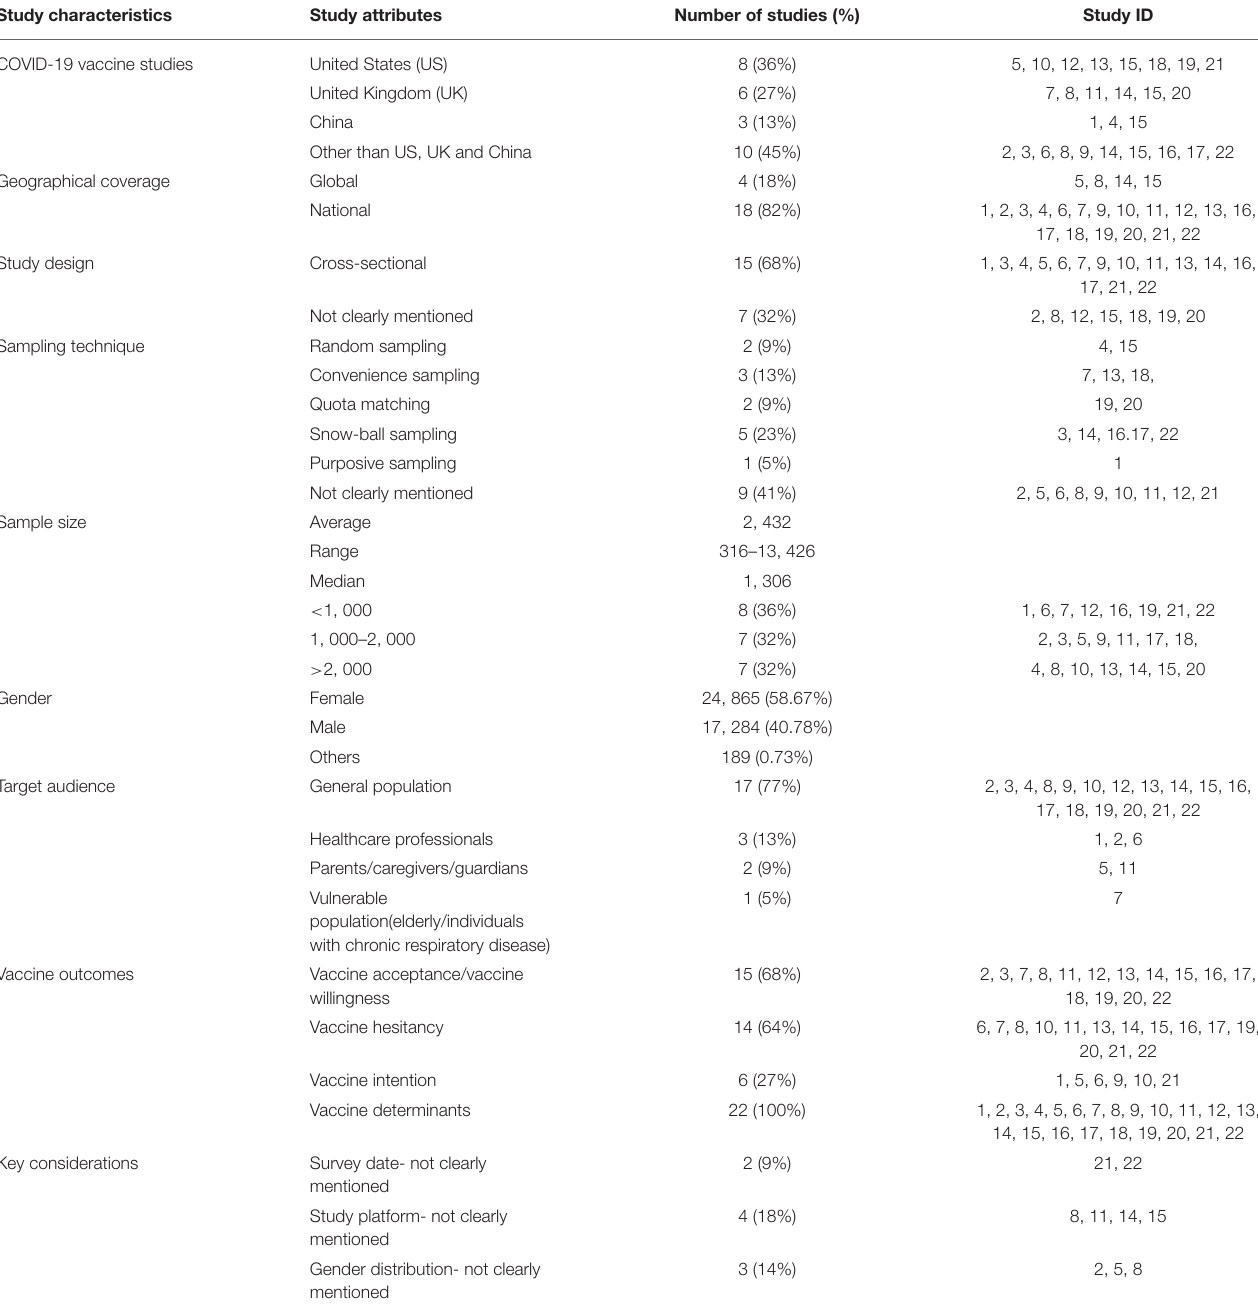
TABLE 1 | Descriptive analysis of the included